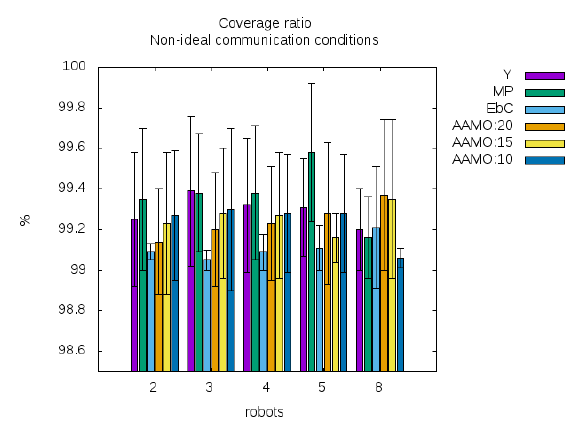
Figure 17. AAMO Coverage ratio. Regardless of how different the HO-Threshold values are, in all cases, the AAMO approach can cover more than 99% of the terrain.